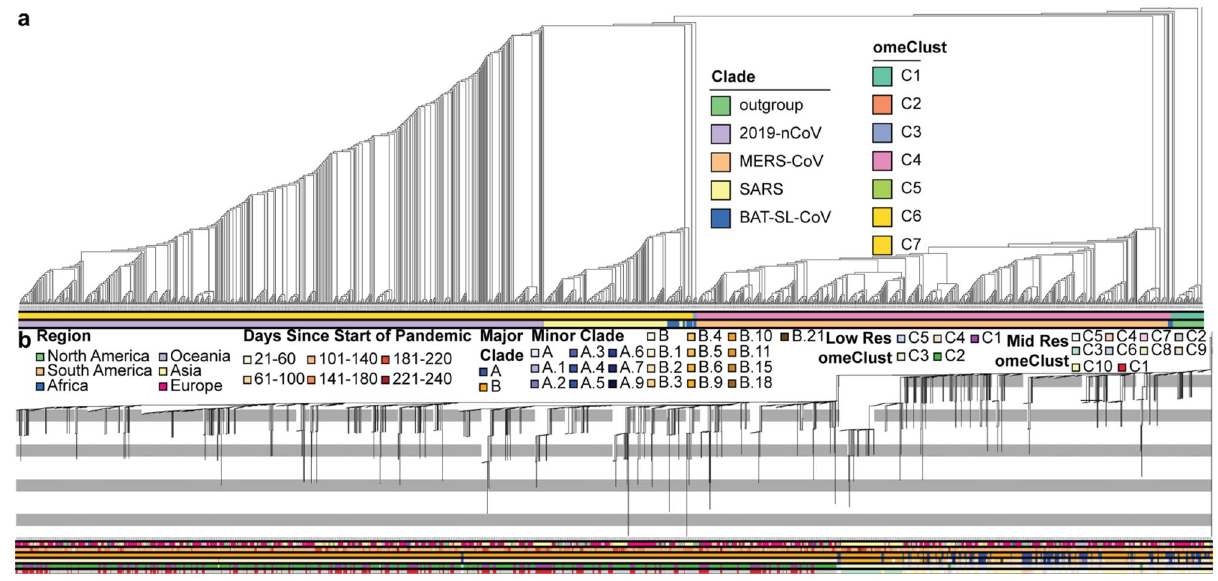
Figure 1. Maximum Likelihood analysis of the nsp3 region of the CoV genomes. ( a ) RAxML cladogram (branch lengths not proportional to change) showing relationships between SARS-CoV-2, MERS, Bat-SL-CoV, and SARS-related and rooted using a Beta Coronavirus outgroup. Sequence identity estimates between the representatives of clades for CoV families reveal regions with potential functional importance. ( b ) RAxML phylogram (branch lengths proportional to change) estimated from 2,007 sequences from the GISAID database, including proportional representatives of genomes from Pangolin major